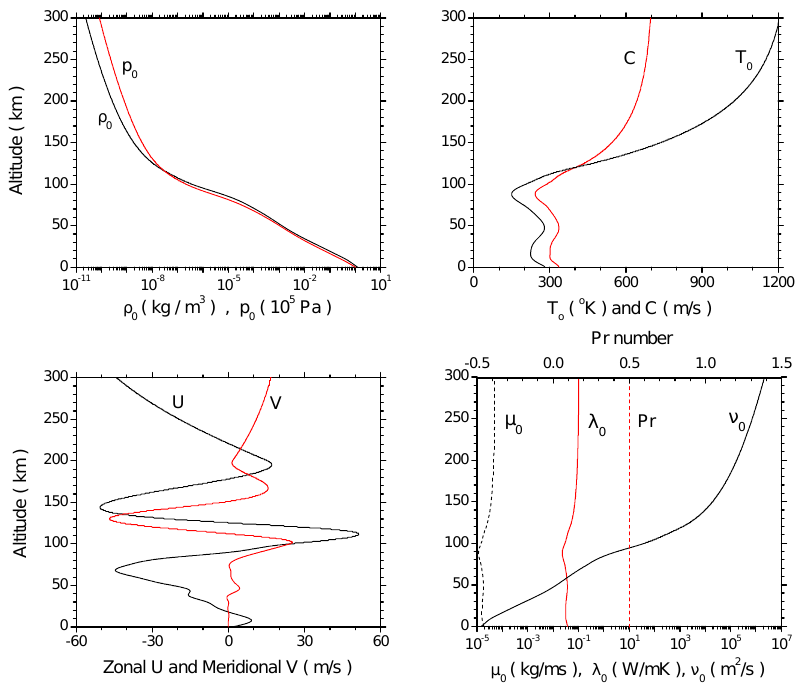
Figure 1. Altitude profiles of atmospheric mean-field properties from the neutral atmospheric empirical model NRLMSISE-00 [77] and the horizontal wind model HWM93